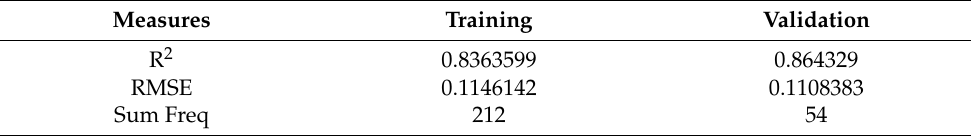
Table 3. Training and Validation parameters for GFRP-made RC columns Efficiency using